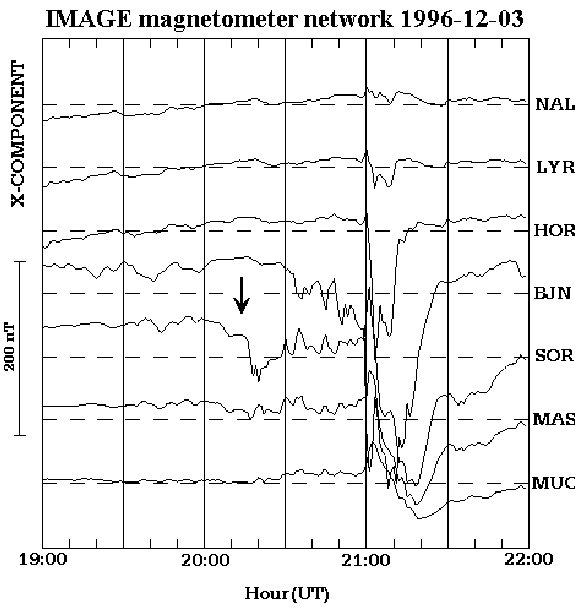
Fig. 3. Magnetograms of the IMAGE network stations for 3 Decem- ber 1996. The arrow marks the onset of auroral hiss near 20:13 UT on INTERBALL-2 (Fig. 2). The very weak magnetic disturbance about 50nT started almost simultaneously with the appearance of auroral hiss. The disturbance is visible only on one single station (Soroya at a geomag. latitude of 67.2 ◦ ). Fig. 4. Relationships between the low frequency cutoff of auroral